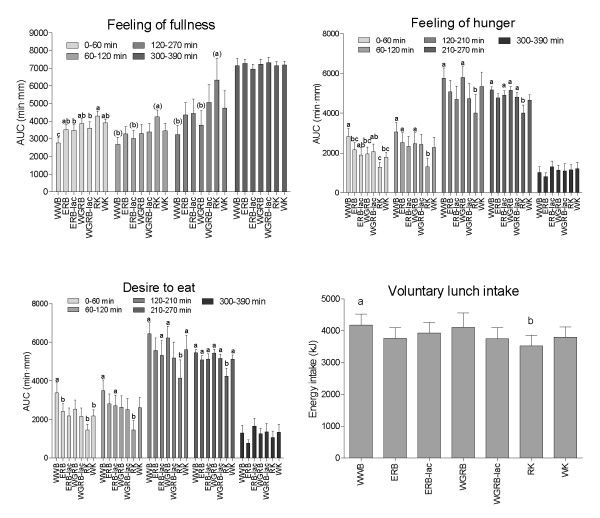
Subjective satiety and voluntary energy intake at lunch after the cereal test breakfasts. Values are means ± SEM, n = 10 (n = 9 for WGRB). Products not sharing the same letters were significantly different. Products not displaying letters were not different from any other test product, p < 0.05 (ANCOVA, followed by Tukey's test). ( ) indicates that the ANCOVA did not have normal distributed residuals, p < 0.05. Voluntary lunch intake was analyzed with ANOVA followed by Tukey's test